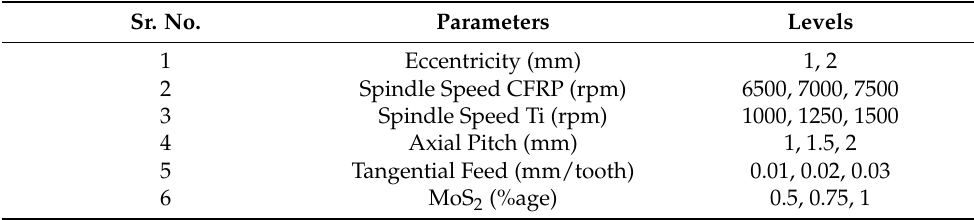
Table 2. Experimental design to characterise parametric effects.